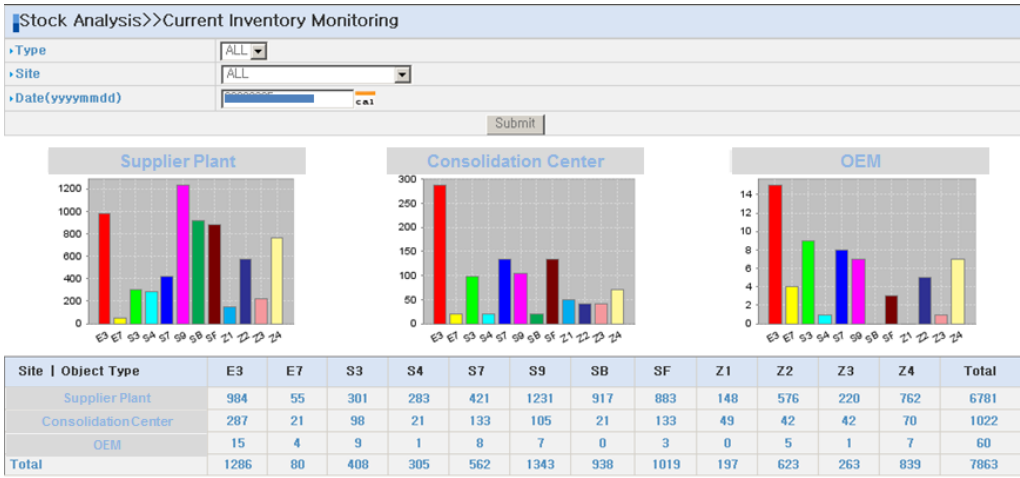
Figure 11. The real ‐ time inventory monitoring application. Figure 11. The real-time inventory monitoring